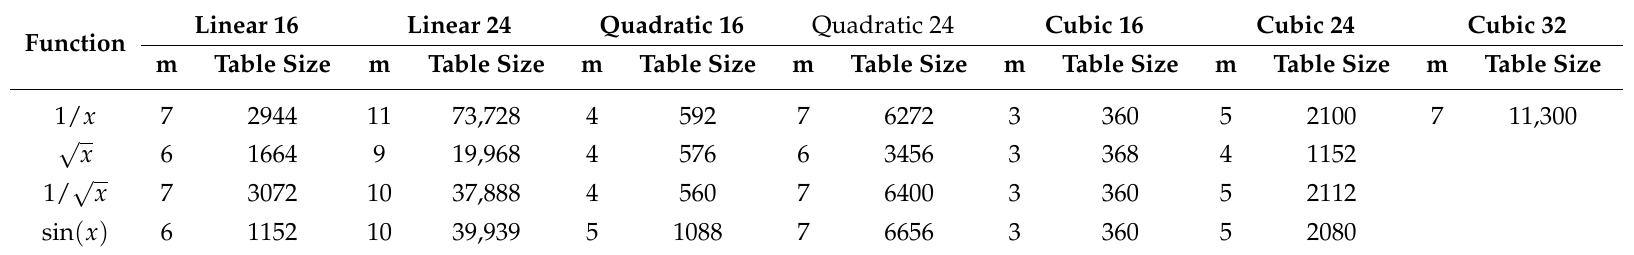
Table 5. Optimized bit-widths and lookup table sizes for various